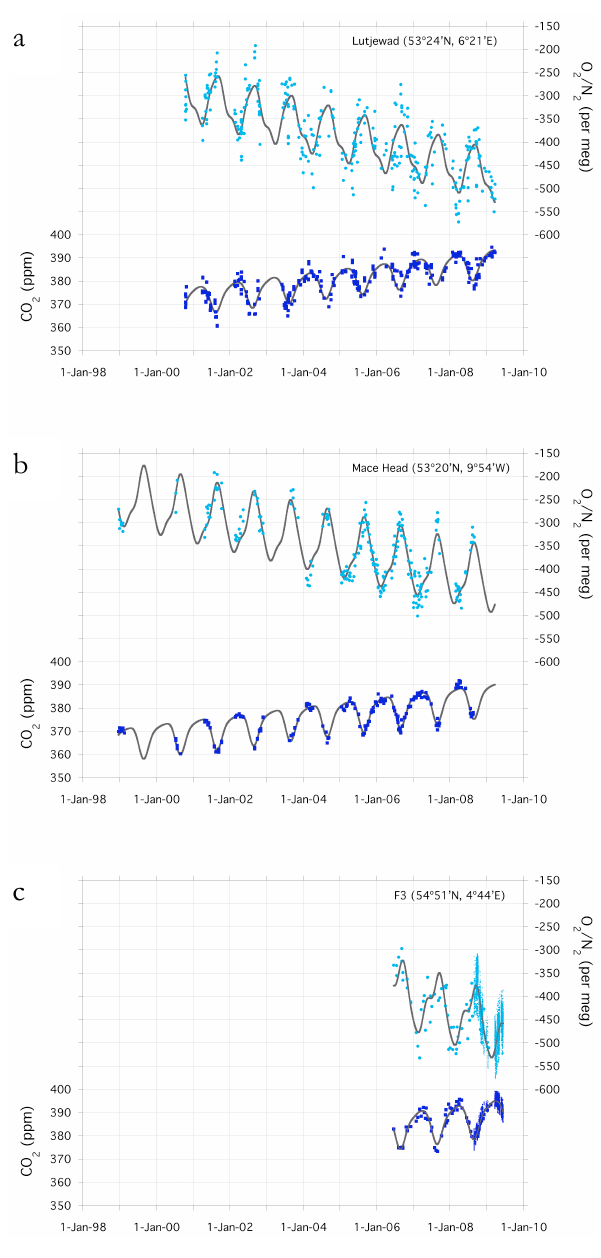
Figure 3 : Observations of the atmospheric O (lighter circles) and CO (darker Fig. 3. Observations of the atmospheric O 2 (lighter circles) and 2 2 CO 2 (darker squares) concentrations at station Lutjewad (a) , Mace squares) concentrations at station Lutjewad (a), Mace Head (b) and F3 (c) during Head (b) and F3 (c) during 1998–2009, based on flask measure- 2000-2009, based on flask measurements. The fits through the data points are a ments (and continuous measurements for F3). The fits through the combination of a three harmonic function and a linear data points are a combination of a three harmonic function and a linear trend.